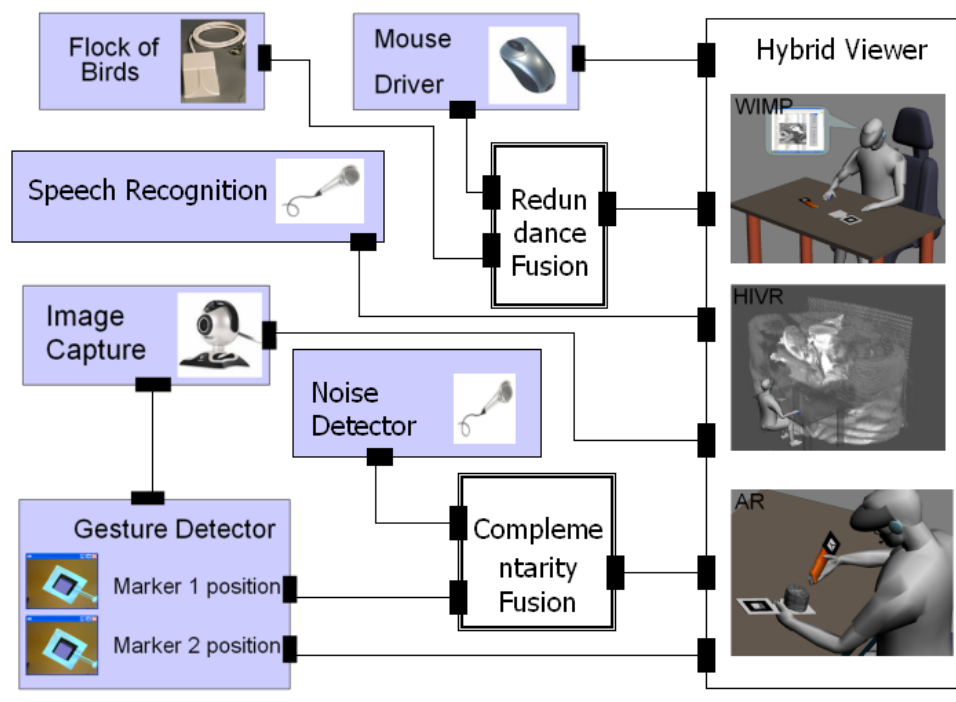
Fig. 5. Initial conception of interactions within the example application scenario.